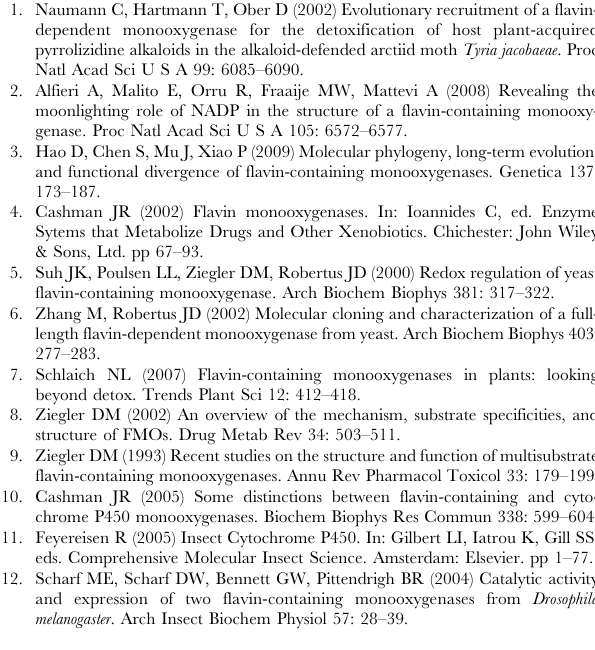
Figure S1 Amino acid alignment of flavin-dependent monoox- ygenases of various lepidopteren species.